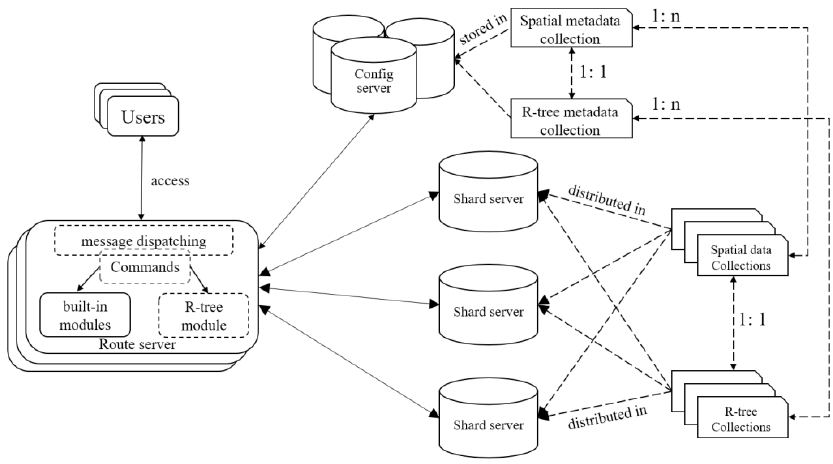
Figure 4. The MongoDB-oriented R-tree integration framework.